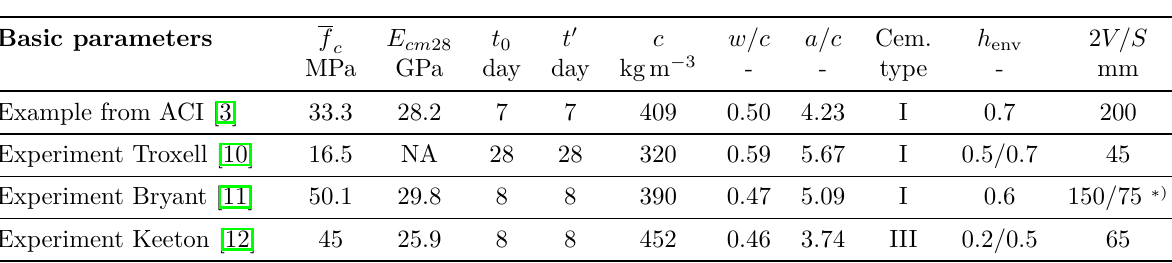
Table 1. Details of the experimental setup in the creep and shrinkage experiments.